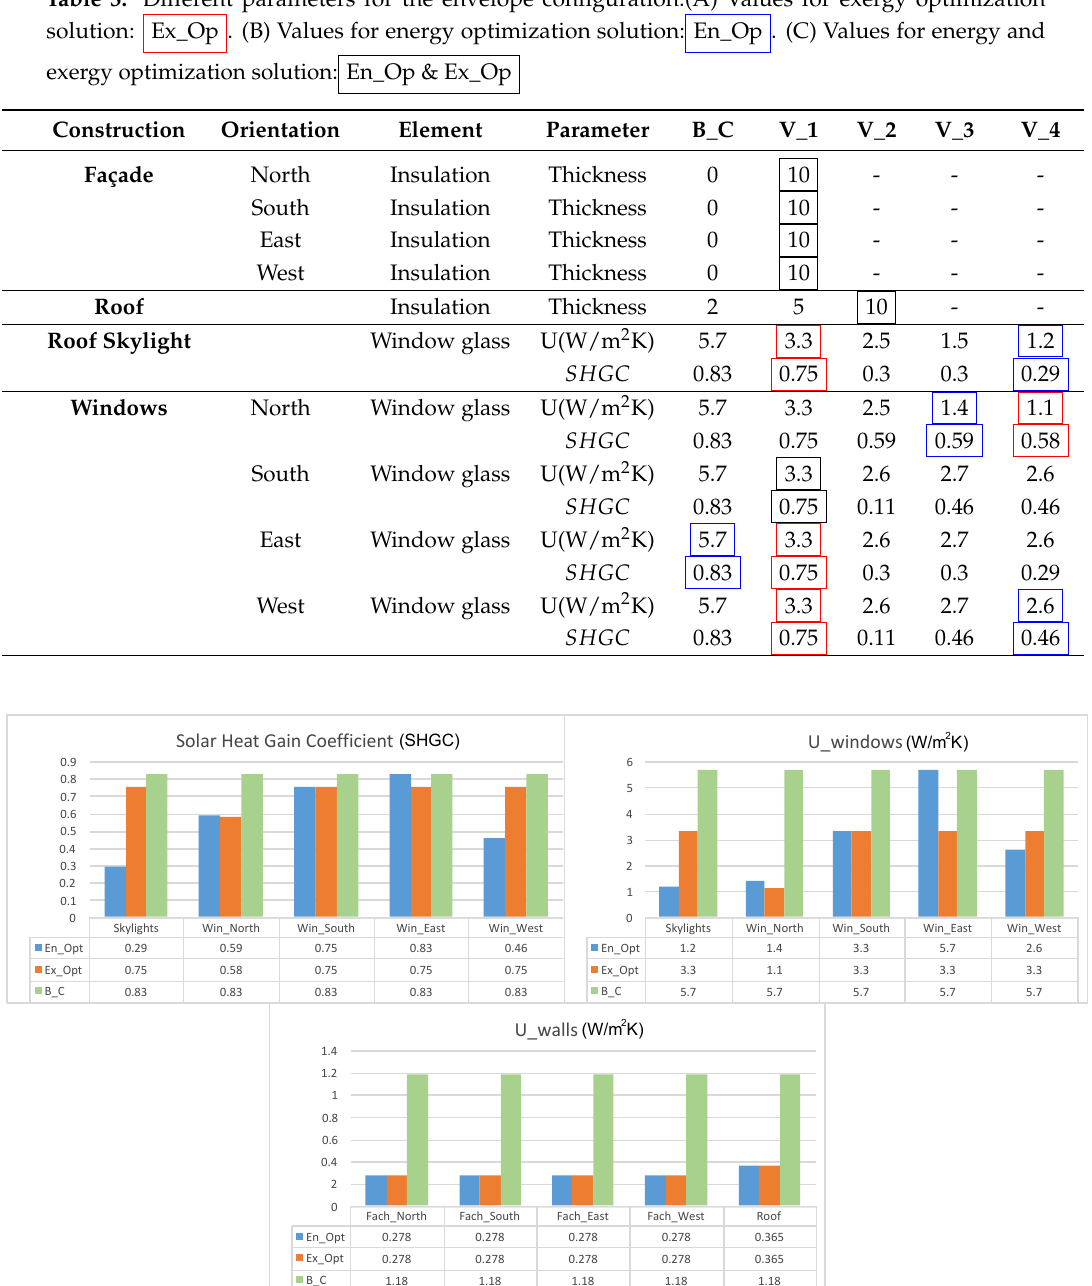
Table 3. Different parameters for the envelope configuration.(A) Values for exergy optimization